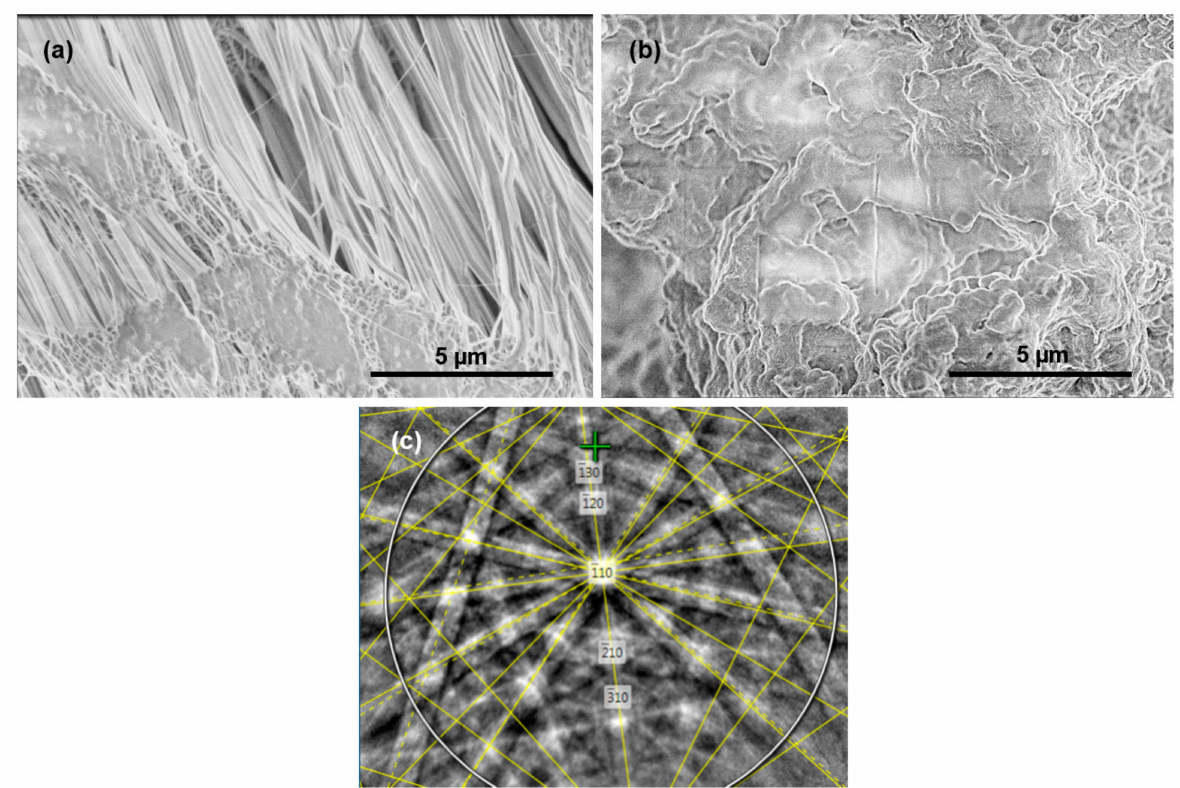
Figure 3. FESEM images of ( a ) as-received PTFE and ( b ) PTFE after laser annealing (rGO). ( c ) EBSD Kikuchi pattern from rGO, exhibiting the characteristic rGO